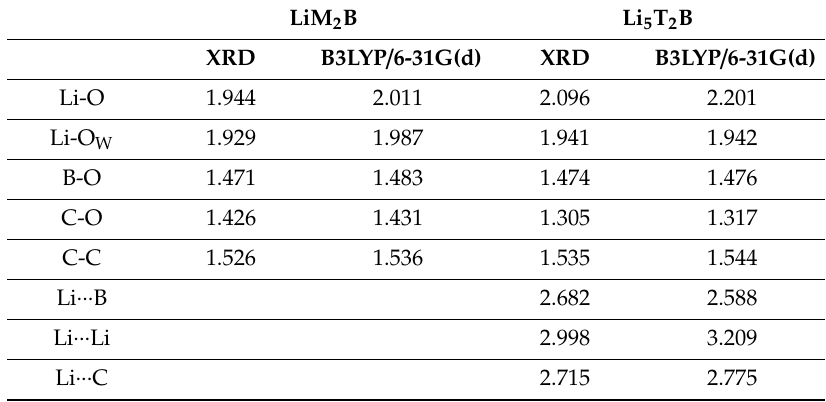
Table 1. Comparison between media values of selected atomic distances (Å) obtained from XRD experiment and computational optimization at B3LYP / 6-31G(d) level of theory for LiM 2 B. LiM 2 B B3LYP / 6-31G(d)